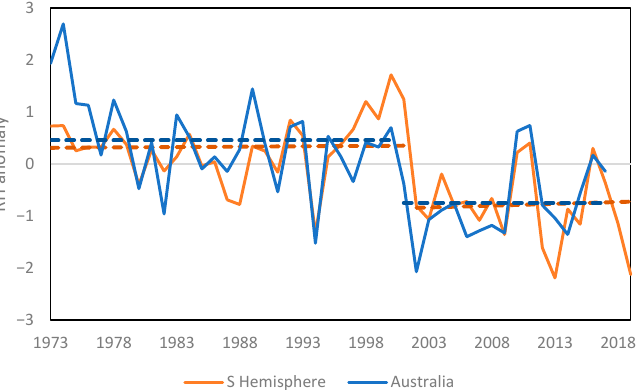
Figure 7. Mean daily average anomalies for RH from Southern Hemisphere land (HadISDH) and Australia [54] , the latter as standard anomalies.